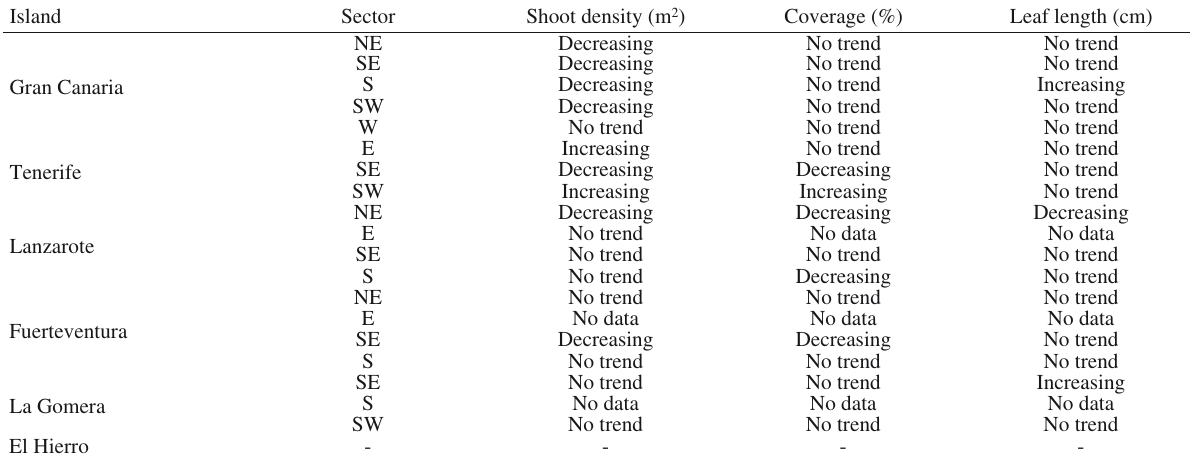
the island sector scale.